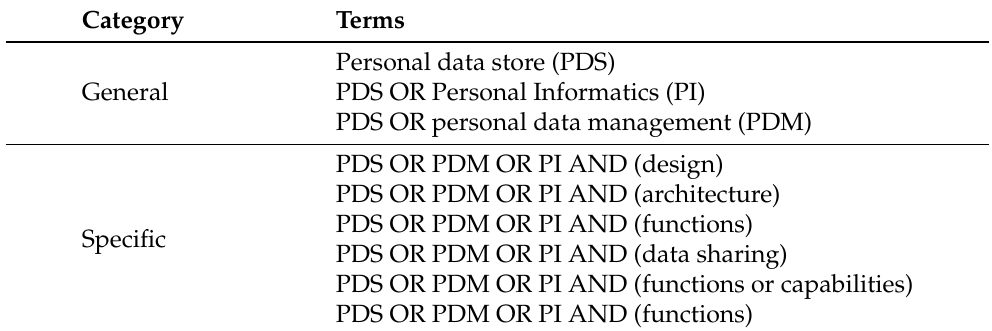
Table 1. Terms used for online search.